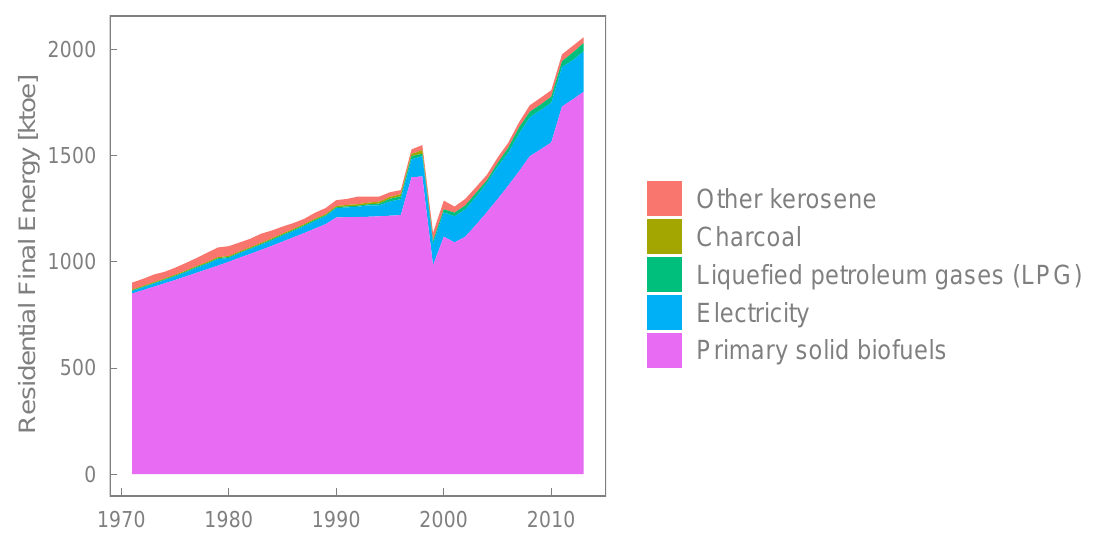
Figure 5. Final energy carriers for the Honduran residential sector (1971–2013) [17]. The discontinuity between 1998 and 1999 is attributed the impact of Hurricane Mitch and a change in energy accounting methods.